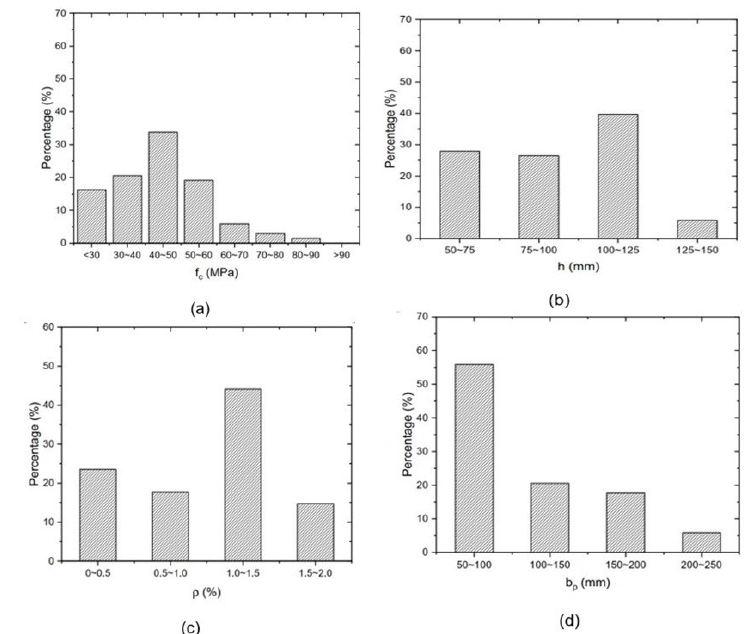
Figure 3. Dispersion of